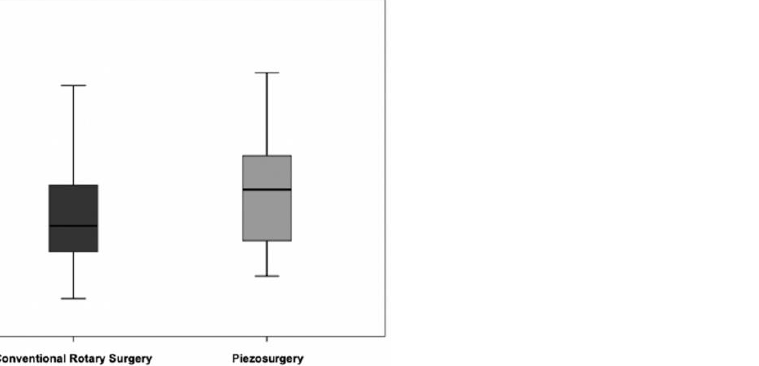
Figure 8. Operative time vs. surgical technique ( p = 0.271 for the comparison between the two tech- niques).